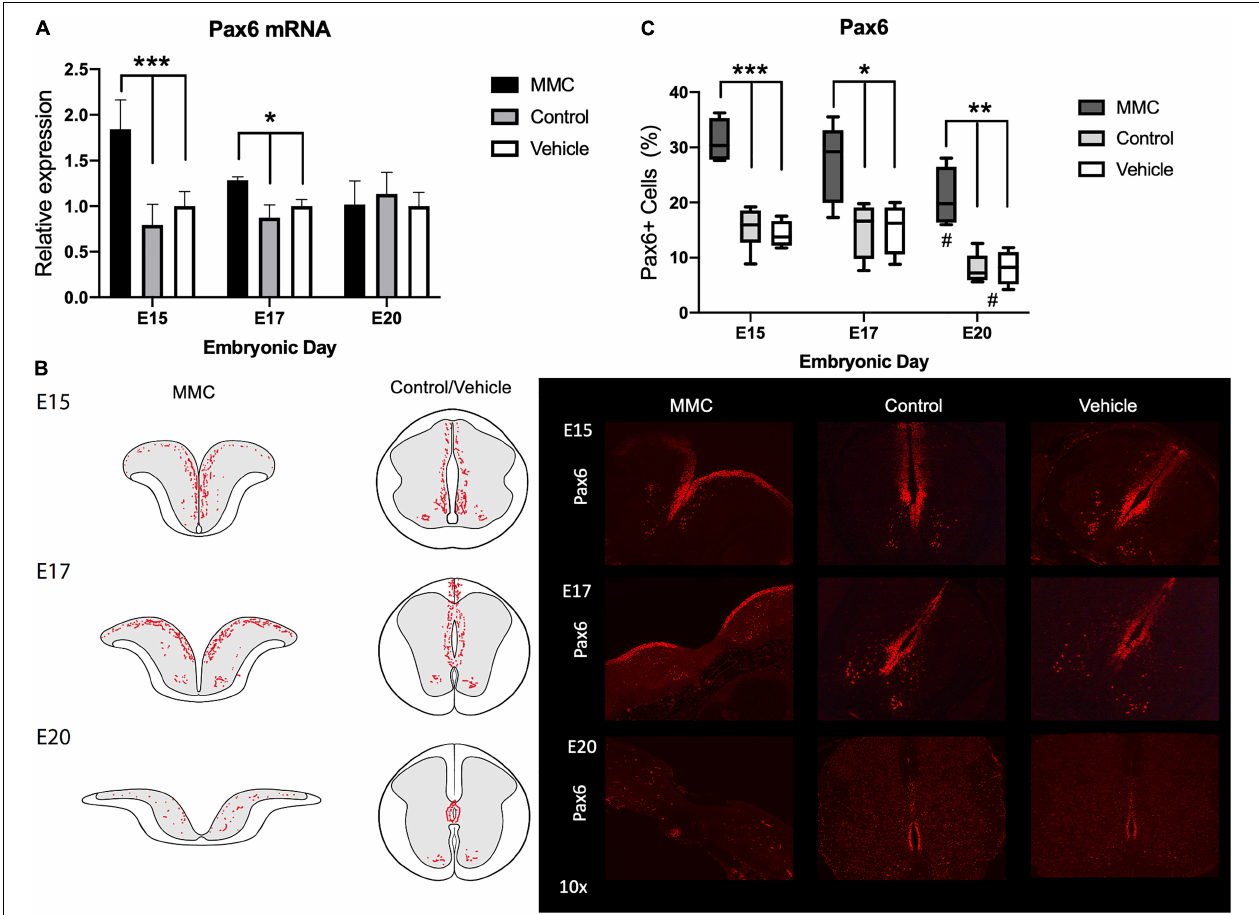
FIGURE 6 | Pax6 expression and distribution in spina bifida. (A) Pax6 relative expression increased in spina bifida (MMC) compared with control and vehicle spinal cords at E15 and E17. Values (means ± SE, 6 fetuses/group) of relative expression (2 – (cid:49)(cid:49) Ct ) for RA-treated and time-matched controls (* p < 0.05, *** p < 0.001). (B) Schematic representation of Pax6 distribution in MMC and control fetal spinal cords at E15, E17, and E20 (left). Pax6+ staining in MMC, control, and vehicle spinal cords at E15, E17, and E20 (right) (10 × ). Pax6+ (red) immunoreactive NPC cells exposed at E15, E17, and E20 in spina bifida (10 × ). (C) % Pax6+ NPC in spina bifida, control and vehicle spinal cords determined by Pax6 stained cells/total cells at three gestational ages E15, E17, and E20 (means ± SD, * p < 0.05, ** p < 0.01, * p < 0.001, # p < 0.05 between E20 and